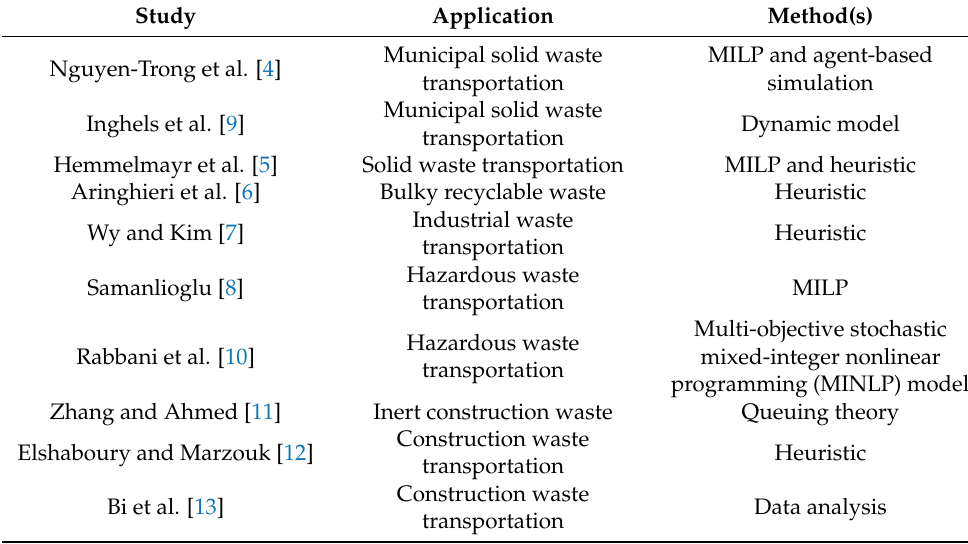
Table 1. Summary of waste transportation